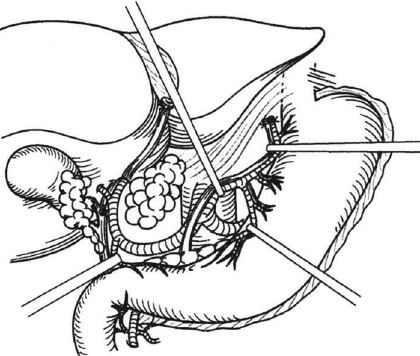
Figure 1: Cancer cells tend to invade the muscle layer of the encir- cled area of the right hemidiaphragm, where is the boundary of bare area and peritoneal reflection. Bare area below the invaded.